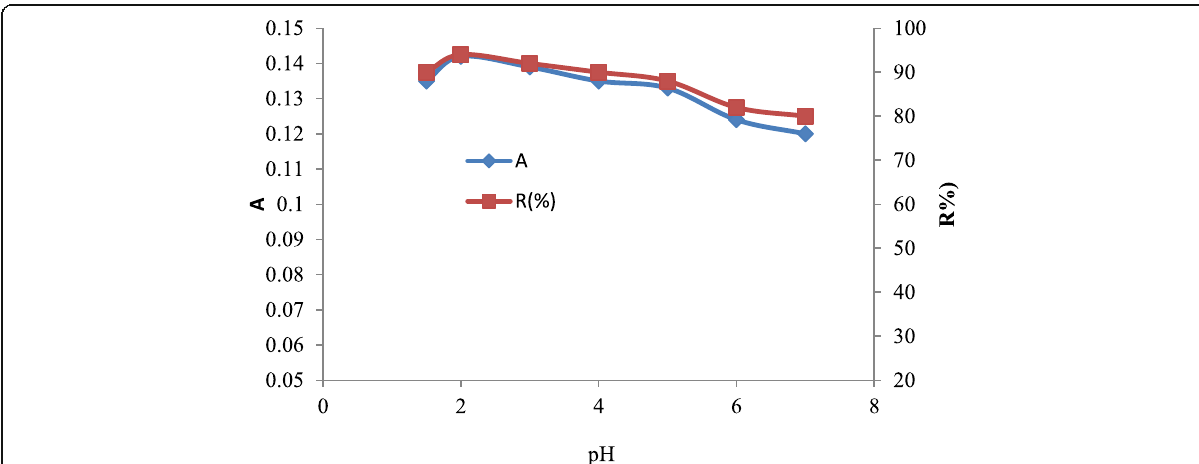
Fig. 2 Effect of solution pH on the extraction of Cu(II) ions by DLLME method. Conditions: sample volume, 10.0 mL; Cu(II) ion concentration, 50.0 μ g L − 1 , salophen concentration, 2.0 × 10 − 5 M; extraction solvent (chloroform) volume, 110 μ L; disperser solvent (acetone) volume, 1.30 mL;